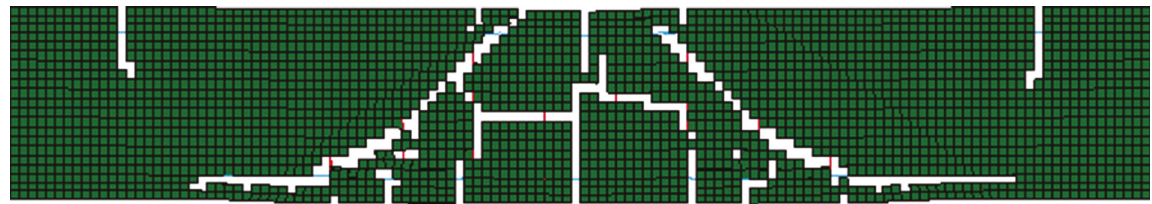
Figure 8: Crack pattern of RC beam simulation (LS-DYNA).